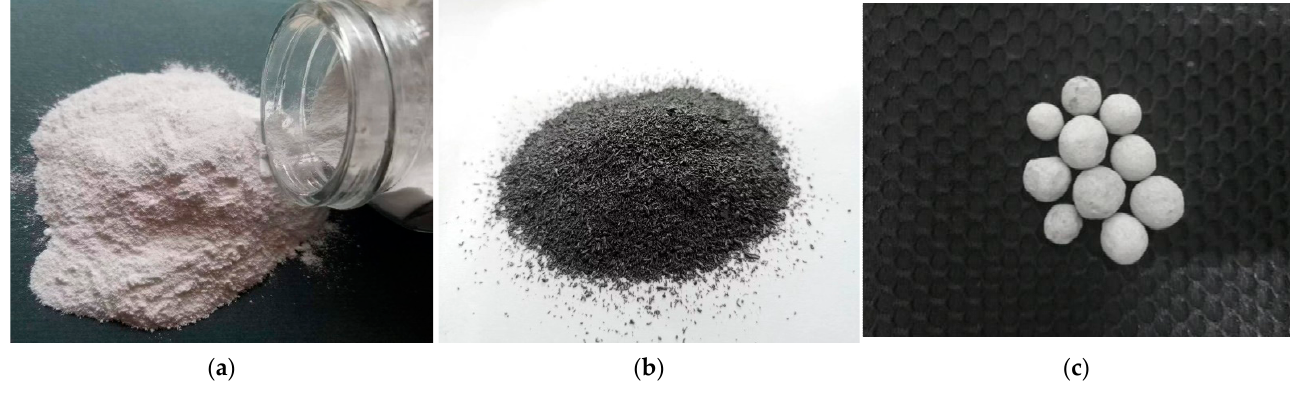
Figure 1. Raw materials: ( a ) PCM-43; ( b ) PCM-48; ( c ) ceramsite. Table 2. Marshall characteristics of asphalt